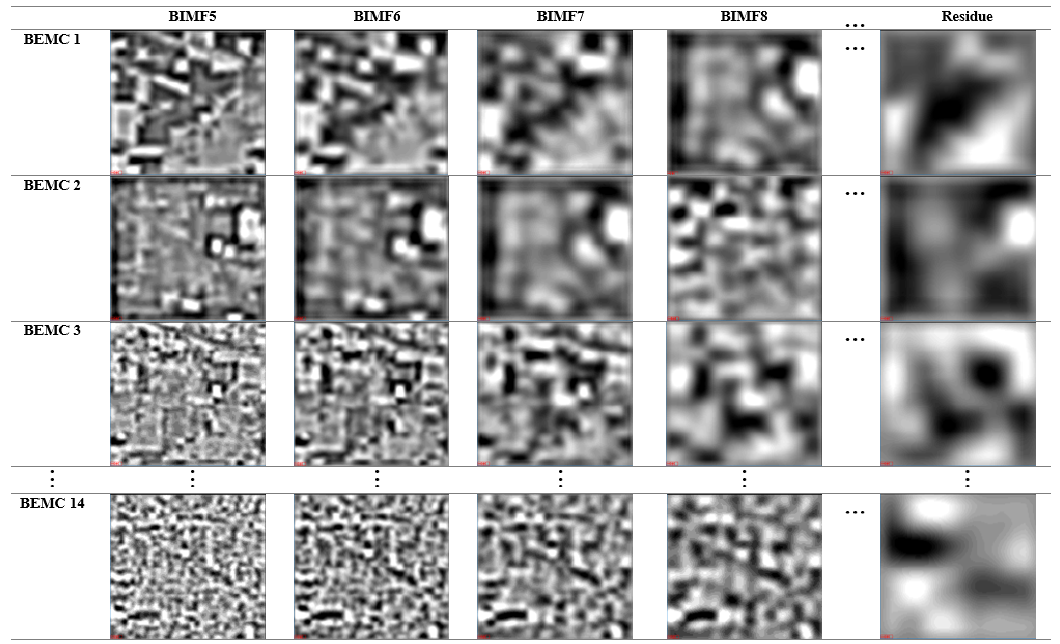
Figure 2. Illustration of the 14 sets of BEMCs with BIMFs and residue image for the IP dataset.